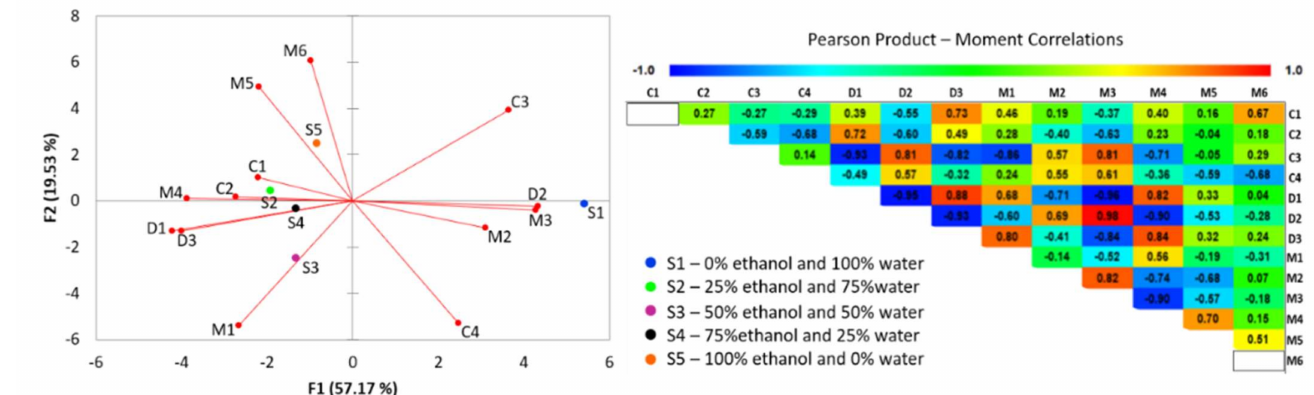
Figure 6. Distribution patterns of 13 variables and 5 different extracts belonging to the Othello grape samples in the two-dimensional space of PC1 and PC2 (the abbreviations of variables are presented in Table